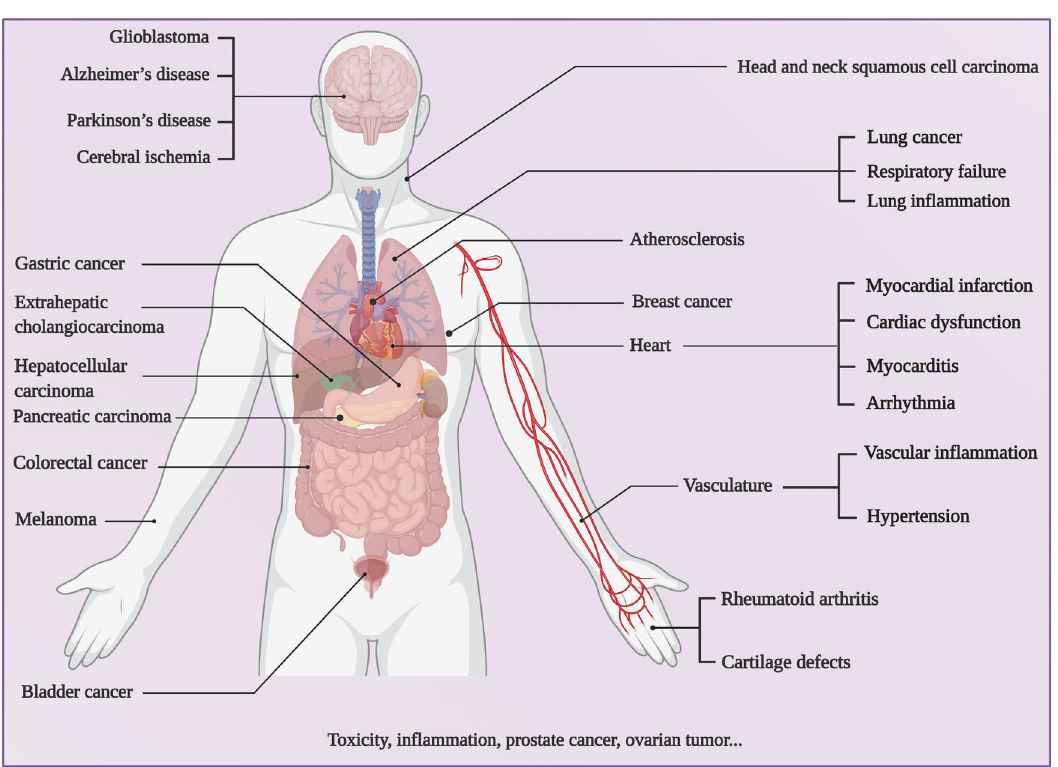
Fig. 6 BNPs ameliorate various diseases via targeted delivery of therapeutic